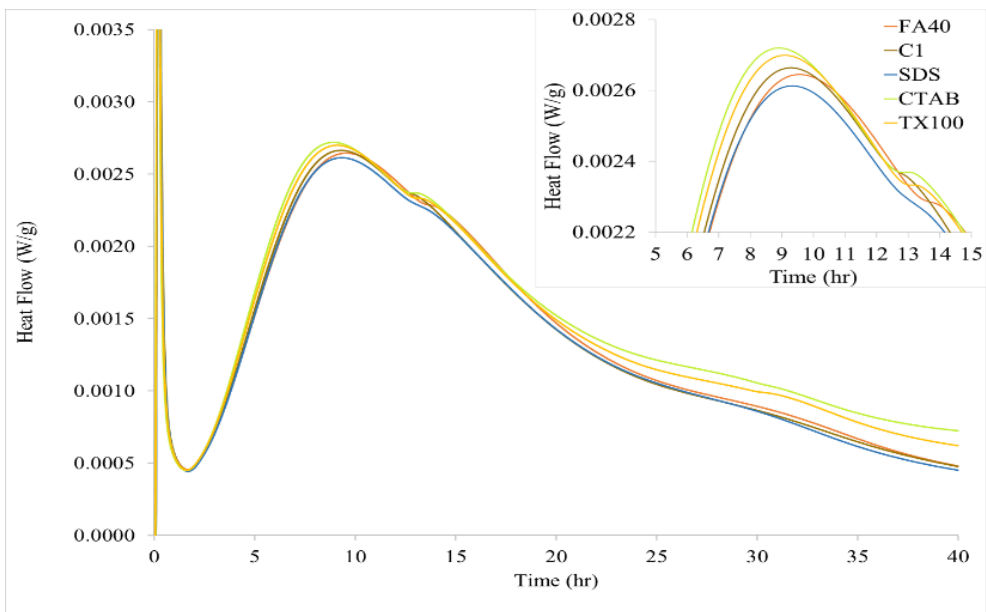
Figure 6. Effect of various synthesized α-Fe 2 O 3 nanoparticles (1.0%) on the heat of hydration of FA blended cement. Inset: Enlarged image for heat flow during stages 3 and 4 showing peak maxima for control FA40 and nanoparticle samples.